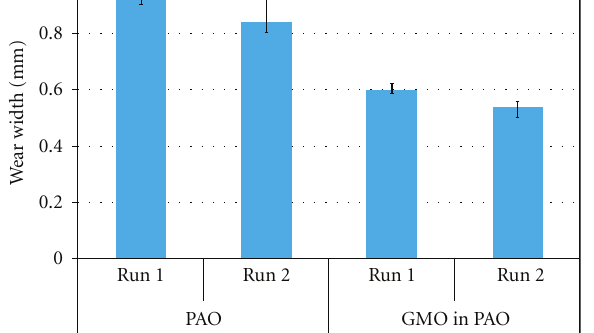
Figure 7: Increase in silicon concentration on aluminium block during running-in period (GMO in PAO).